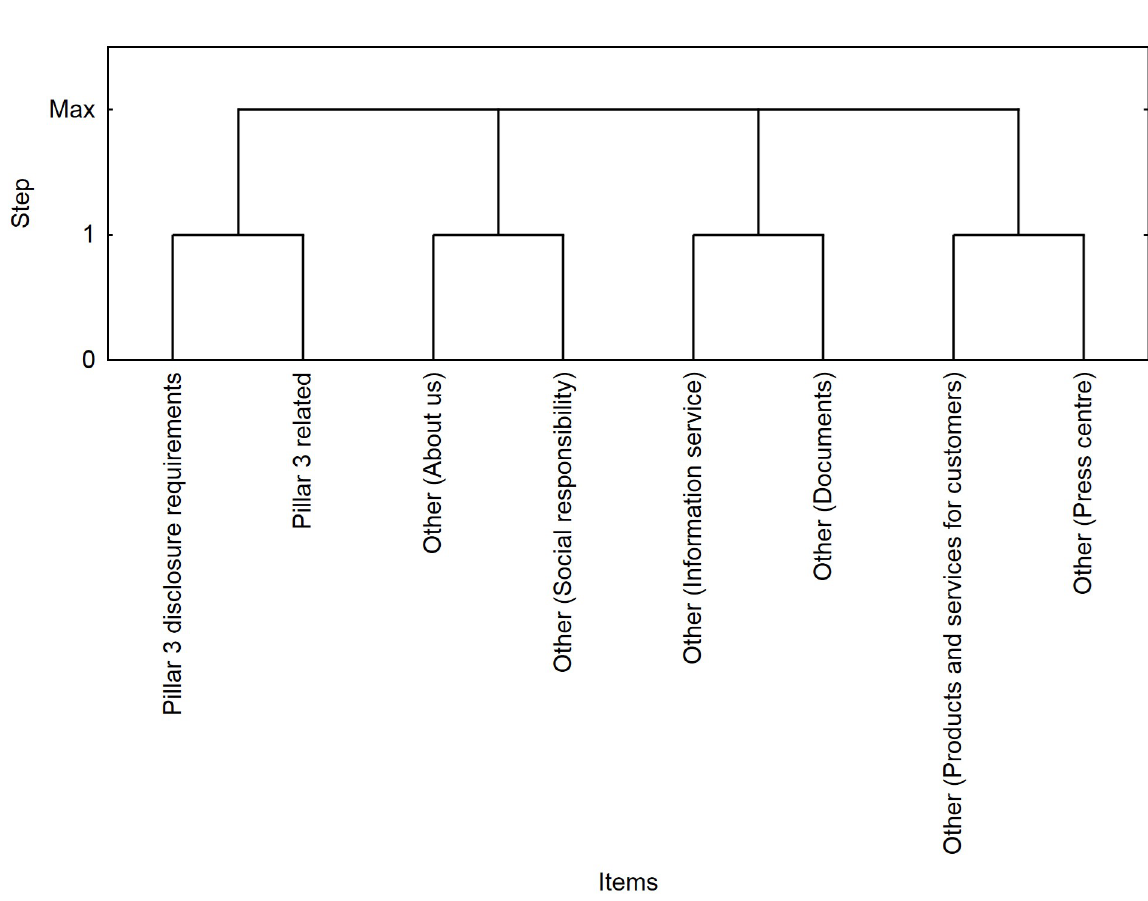
Fig 7. Visualization of seating segments in the third